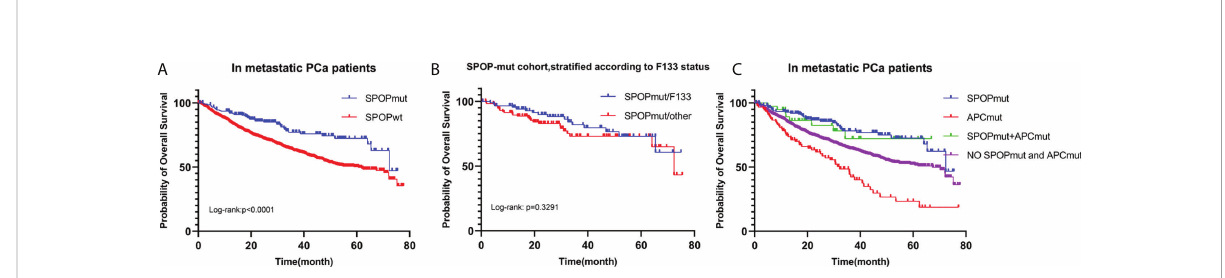
FIGURE 5 OS for metastatic PCa according to SPOP mutation status (A) . Patients with SPOP mutations were further strati fi ed according to F133 mutation site (B) . OS for metastatic PCa in different SPOP/APC mutation groups (C) . SPOPwt, SPOP wild type; SPOPmut, SPOP mutation; APCmut, APC mutation; OS, overall survival.